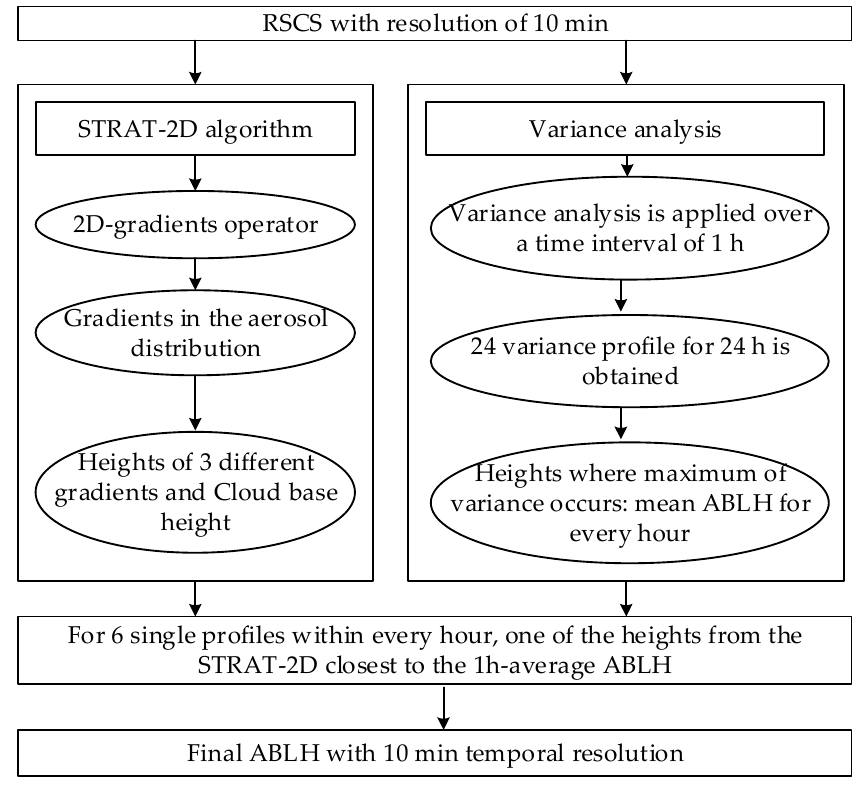
Figure 11. Flowchart for the combination of the STRAT-2D (structure of the atmosphere, 2D version) and VAR in Pal et al. [7].